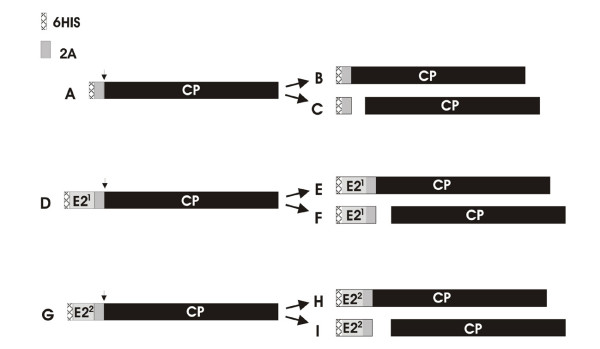
Putative proteins produced. Possible translation products of PVX6His2ACP (A), PVX6HisE212ACP (D) and PVX6HisE222ACP (G). The small arrows indicate where the polyprotein is expected to cleaved at the carboxyl terminus of the 2A. The PVX6His2ACP messenger (A) will be translated either into an uncleaved polyprotein (B) or into two cleaved subunits: 6His2A and CP, respectively (C). The same holds true for the PVX6HisE212ACP (D), which could be translated into an uncleaved polyprotein (E) or into two cleaved subunits: 6HisE212A and CP, respectively (F). Either an uncleaved polyprotein (H) or two cleaved subunits (I) 6HisE222A and CP are expected to be translated from PVX6HisE222ACP (G).